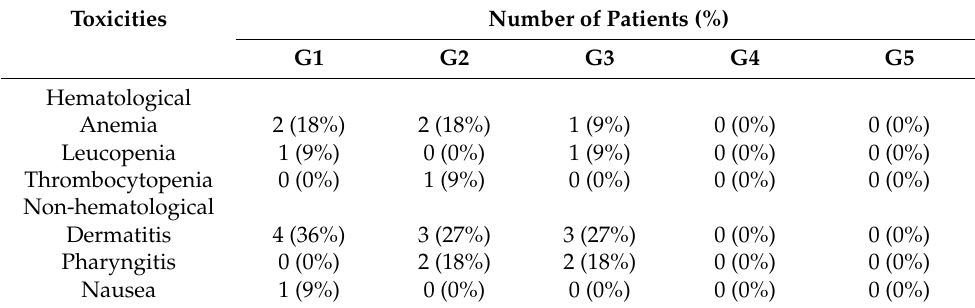
Table 2. Toxicities related to EBRT